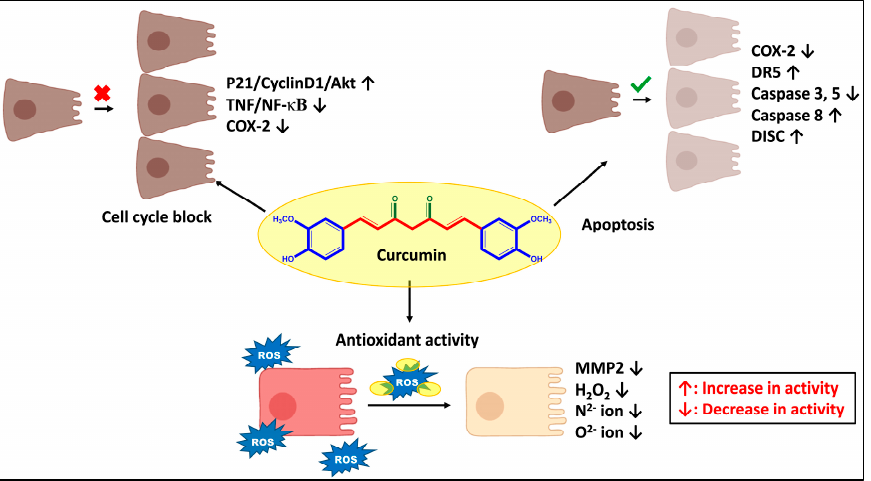
Figure 2. Anticancer mechanism of Curcumin in colon cancer.